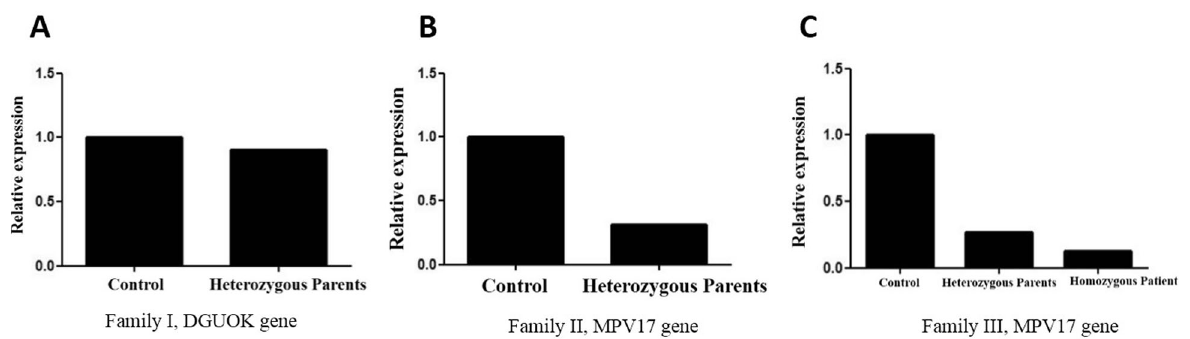
Fig. 2 Quantitative real-time PCR results. a DGUOK mRNA expression levels show no significant differences between heterozygous parents and normal individual. b In family II, MPV17 mRNA expression reduced in heterozygous parents compared with normal control. c Real-time PCR analysis of MPV17 gene in parents and the affected proband in family III and normal control, showing significant reduction in mRNA